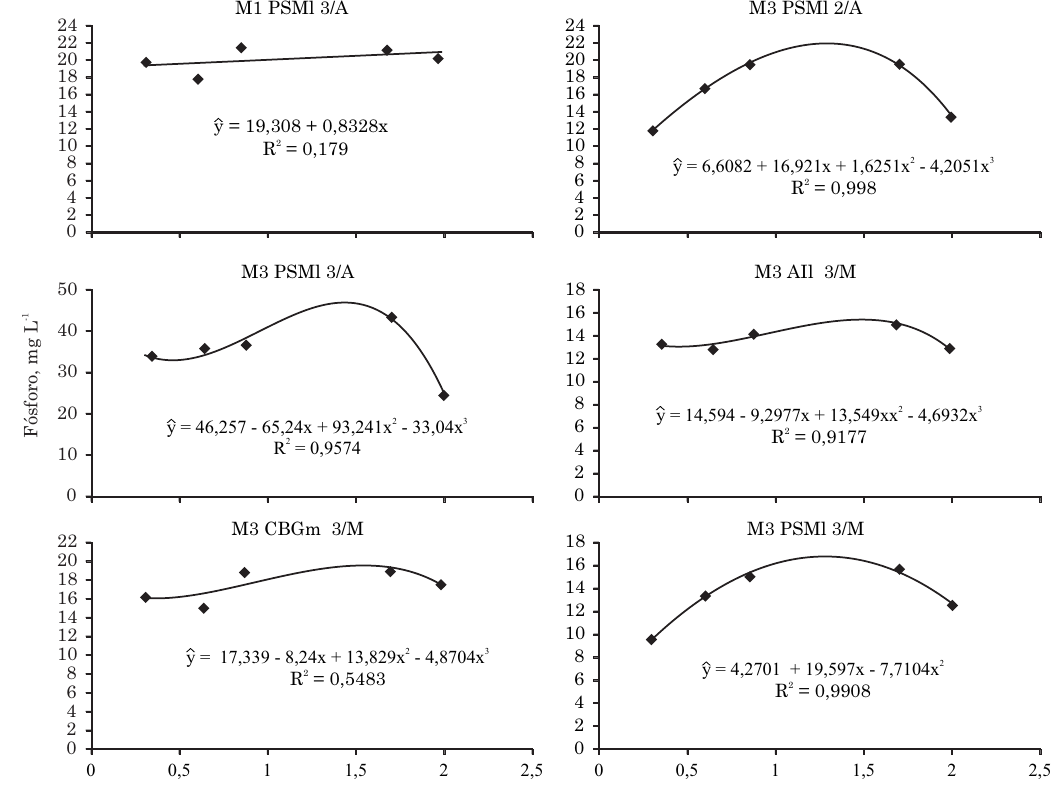
Figura 2. Regressão entre os teores de P extraído pelas soluções Mehlich-1 e Mehlich-3, em diferentes solos e graus de